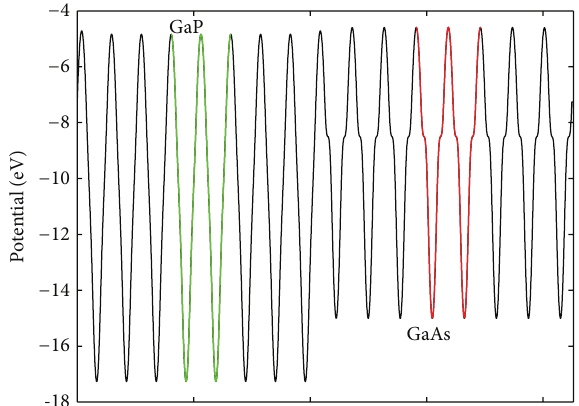
Figure12:EffectivelineupoftheLDAplanaraveragedpotentialsfor GaP and GaAs in a short-period GaAs(8)/GaP(8) [001] superlattice. The planar averaged potentials for bulk GaP and strained GaAs are represented in green and red, respectively. The potential curve of bulk GaP has been downshifted by − 0.66eV in order to fit into the GaP layer of the potential curve of the GaAs(8)/GaP(8) SL. The potential curve of strained GaAs has been upshifted by 0.62 eV in order to fit into the GaAs layer of the potential curve of the GaAs(8)/GaP(8)